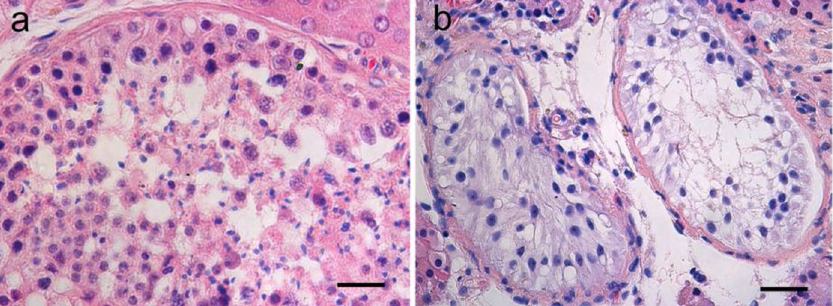
Figure 6. Hematoxylin and eosin staining of testis sections from ( a ) a patient with obstructive azoospermia (OA), and ( b ) the NOA patient carrying the ESX1 p.[P365R; L366V] mutation. Only Sertoli cells could be detected within the testis tissue of this NOA patient (Sertoli-cell-only-syndrome, SCO), whereas the tissue of the OA patient displayed full spermatogenesis. Scale bar: 50